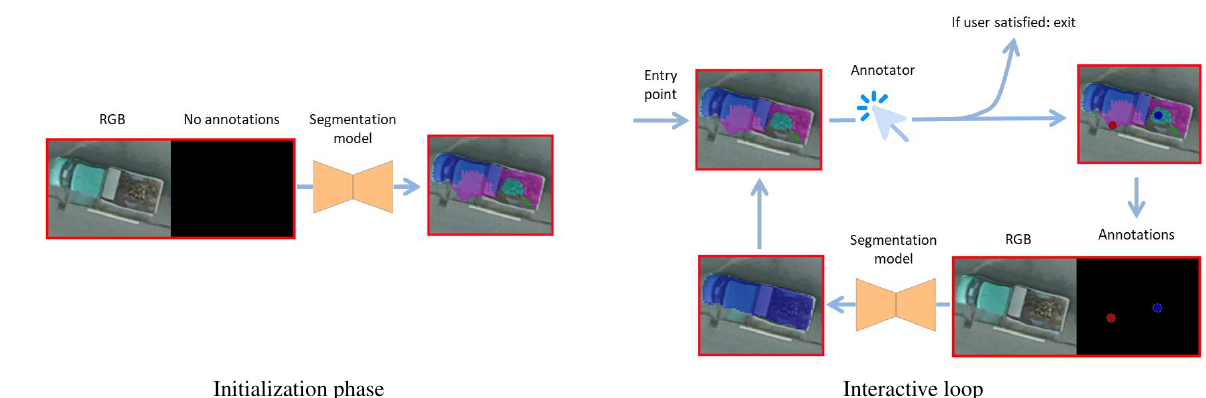
Figure 2. High level overview of the proposed approach: information provided by the user modifies the input of the network - not the network itself - allowing an effective interaction